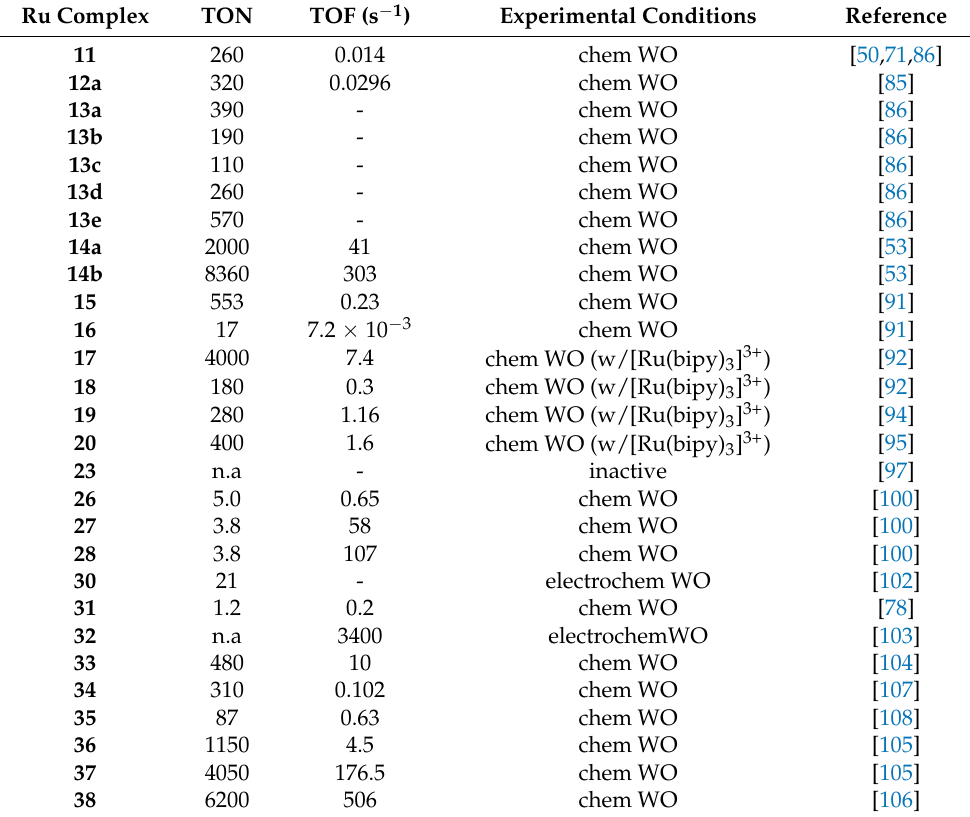
Table 2. Selected catalytic parameters and experimental conditions for Ru catalysts 11–38 in water oxidation. Electrochemical and chemical water oxidation using [Ce(NO 3 ) 6 ][(NH 4 ) 2 ] (CAN) are abbreviated as ‘electrochem WO’ and ‘chem WO’, respectively. The TON or TOF values that are not listed in this table are unavailable in literature